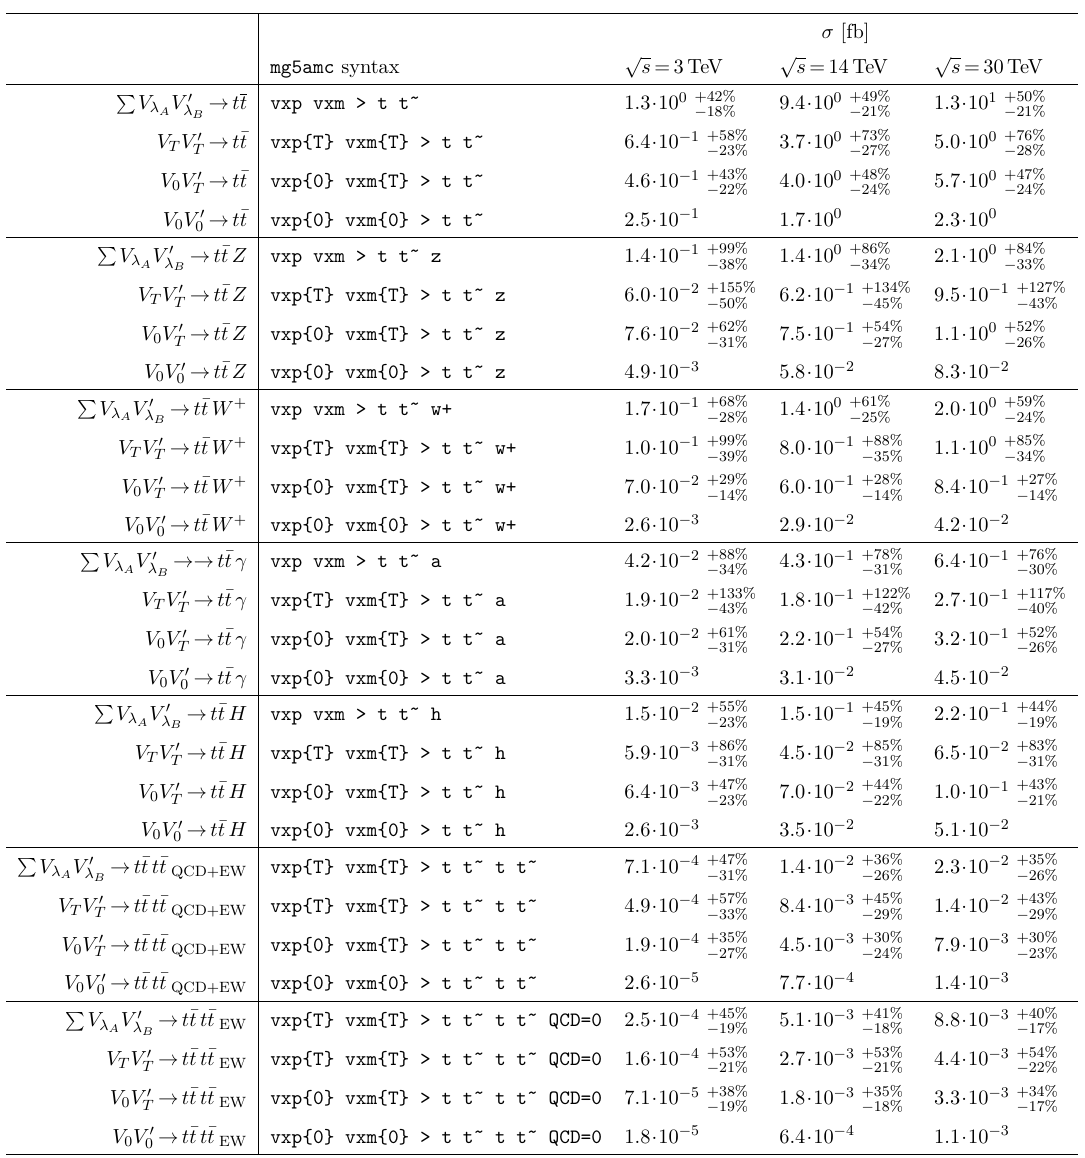
Table 5 . Same as table 4 but for tt pair production and tt associated